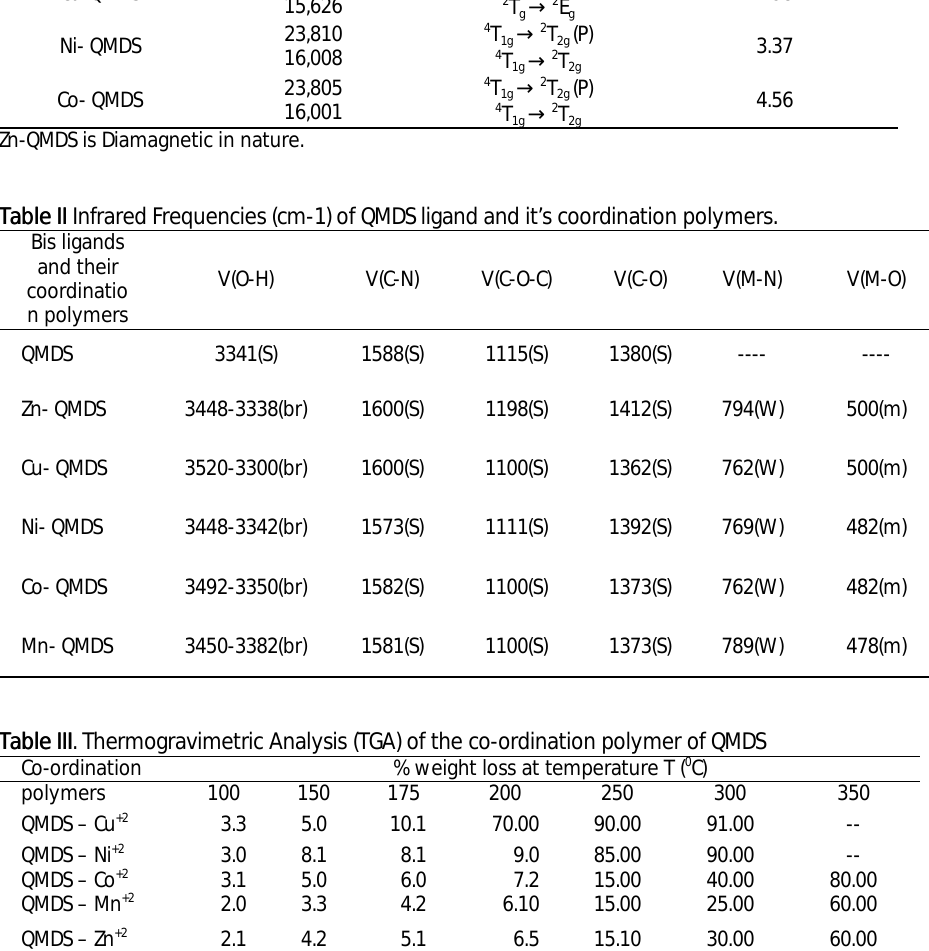
Table IITable II Reflectance spectral and magnetic moment data of the QMDS co-ordination polymers Coordination polymers